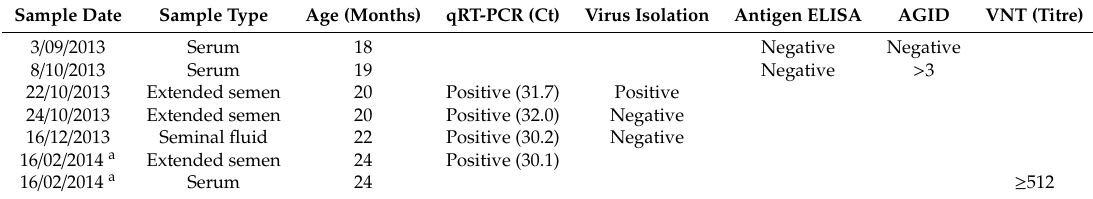
Table A4. Serological and virological test results for Bull